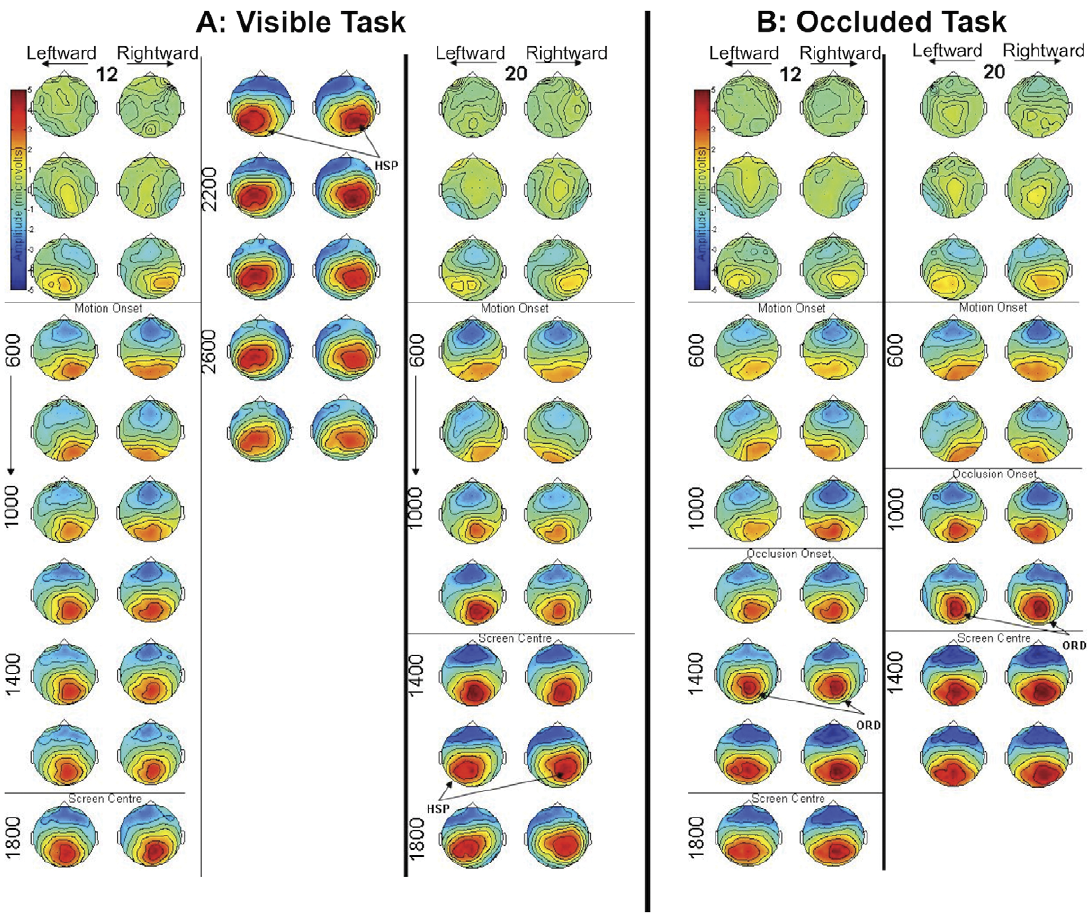
Figure 2. Sequential Topographies. A) Sequential topographies from the Visible Task. B) Sequential topographies from the Occluded Task. In A and B, leftward and rightward motion conditions are placed adjacently. For the Visible task, the 12 u /s condition continues in another column. Each row represents a 200 ms interval. Maps show average amplitude over a 40 ms window around the stated time point. HSP = Hemifield Switch Positivity, ORD = Occlusion Related Deflection.